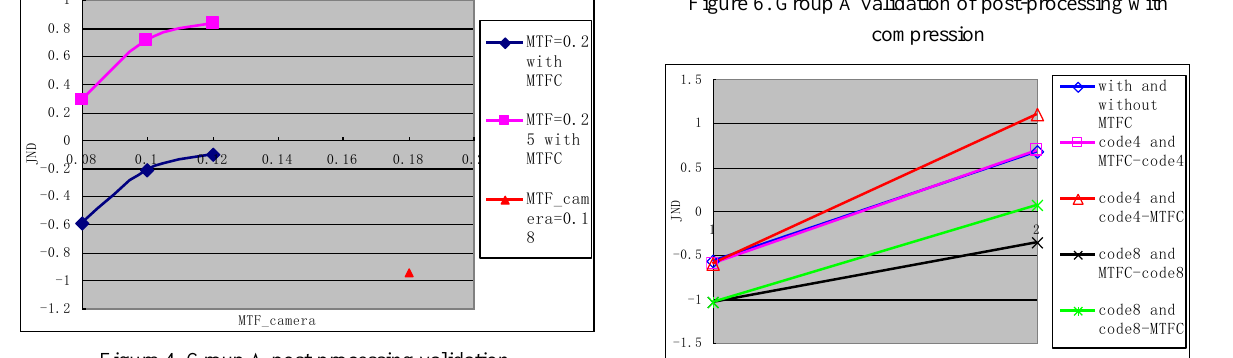
Figure 4. Group A post-processing validation